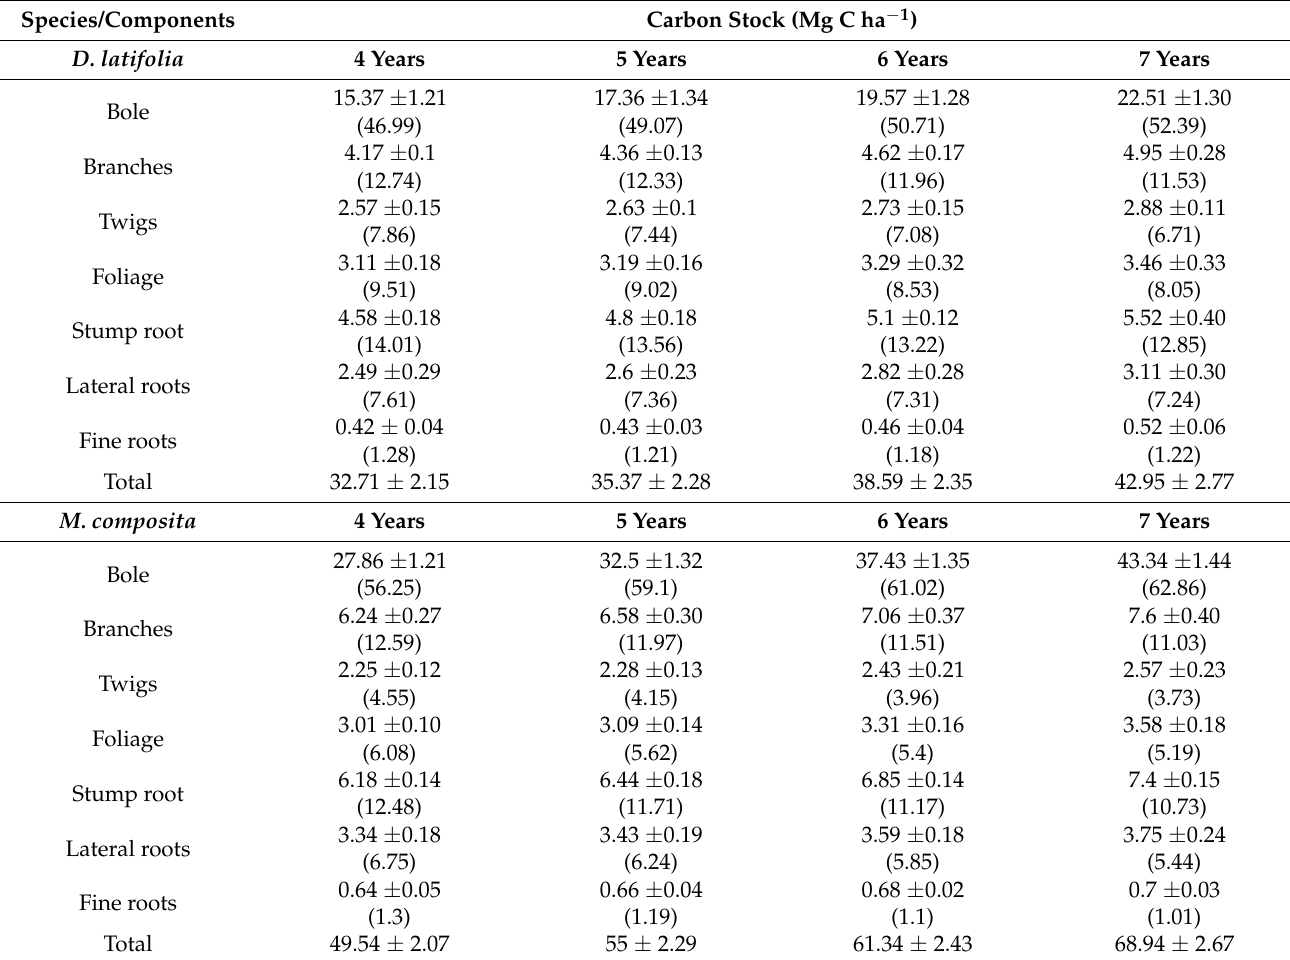
Table 8. Component-wise mean ± SE carbon stock (Mg C ha − 1 ) in all the